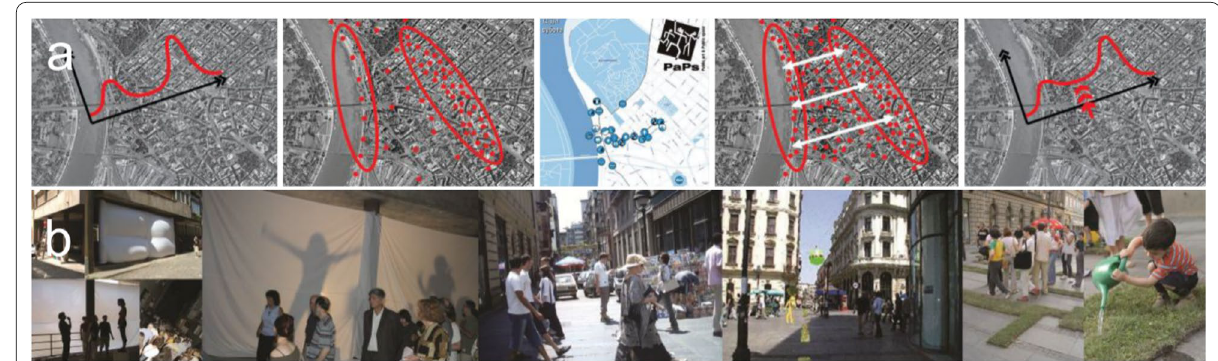
Fig. 7 A step towards river by PaPs (2003); a public art strategy and program; b realization of the